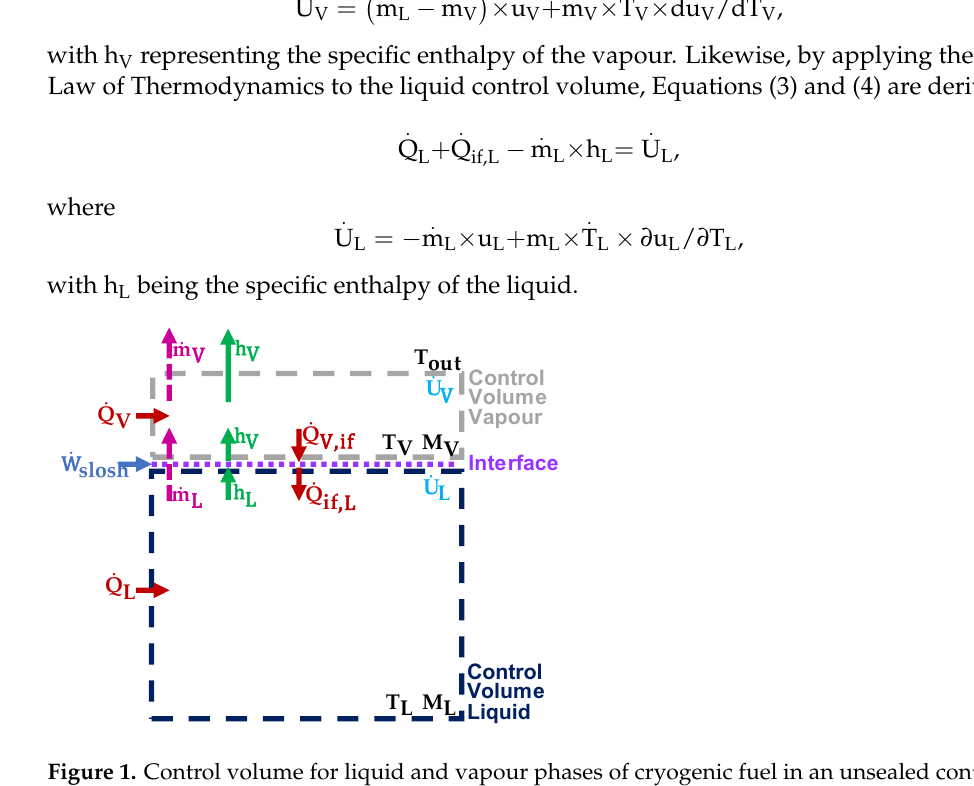
Figure 1. Control volume for liquid and vapour phases of cryogenic fuel in an unsealed container and control surface for the liquid-vapour interface. The cryogenic tank is assumed to operate without reliquefaction. Thermodynamic properties are shown, including the temperature of liquid ( T L ), vapour ( T V ), and external environment ( T out ); the mass of liquid ( M L ) and vapour ( M V ); the heat transfer rate into the liquid ( Q L ), into the vapour ( Q V ) and across the liquid-vapour interface ( Q if ); the rate of change of the internal energy of the liquid ( U ̇ L ) and vapour ( U ̇ V ); the specific enthalpy . flow out of the liquid (h L ) and through the vapour (h V ); the mass flow rate out of the liquid ( m L ) and . . vapour ( m V ) the kinetic energy transfer rate due to sloshing ( W slosh